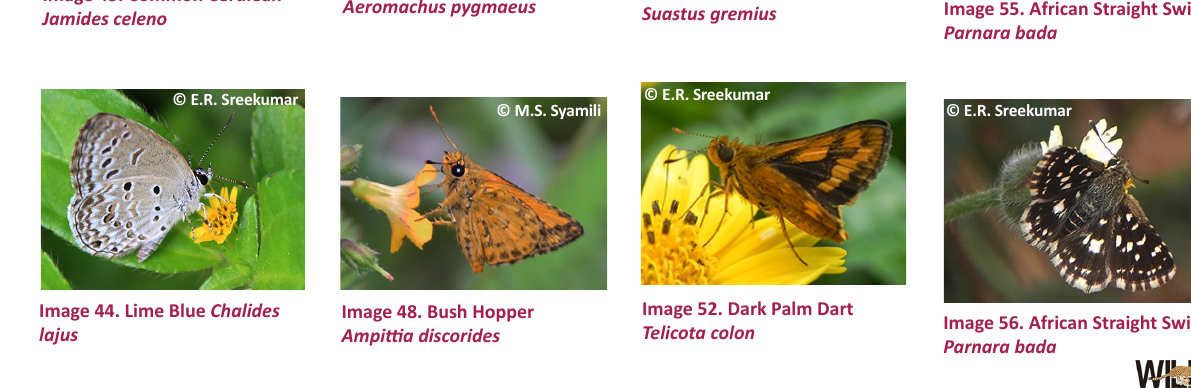
Image 56. African Straight Swift Parnara bada